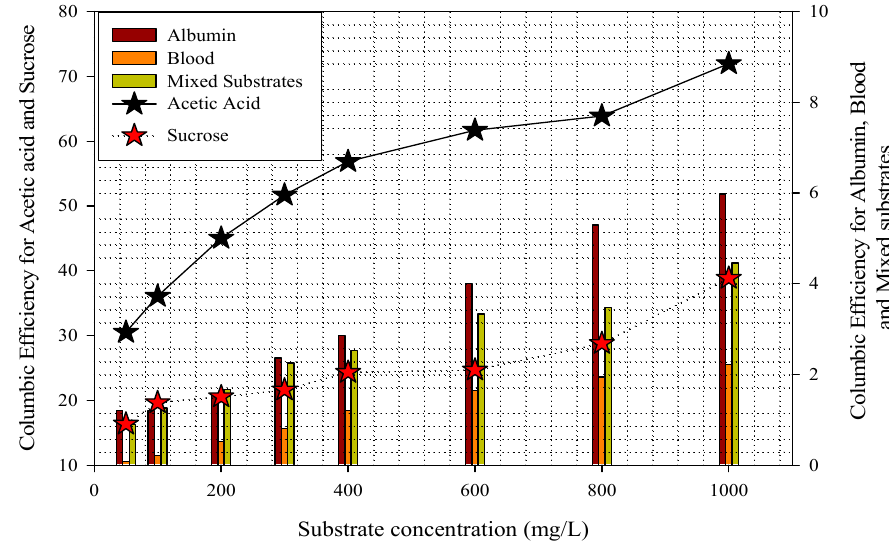
Figure 5. Columbic efficiency of various substrates used in the experiment. Coulombic efficiency indicates how many electrons (from the total electrons generated by a particular substrate) are accepted in electricity generation by the MFC after a particular time. The complexity of the substrates seemed to exert an impact on Coulombic efficiency.